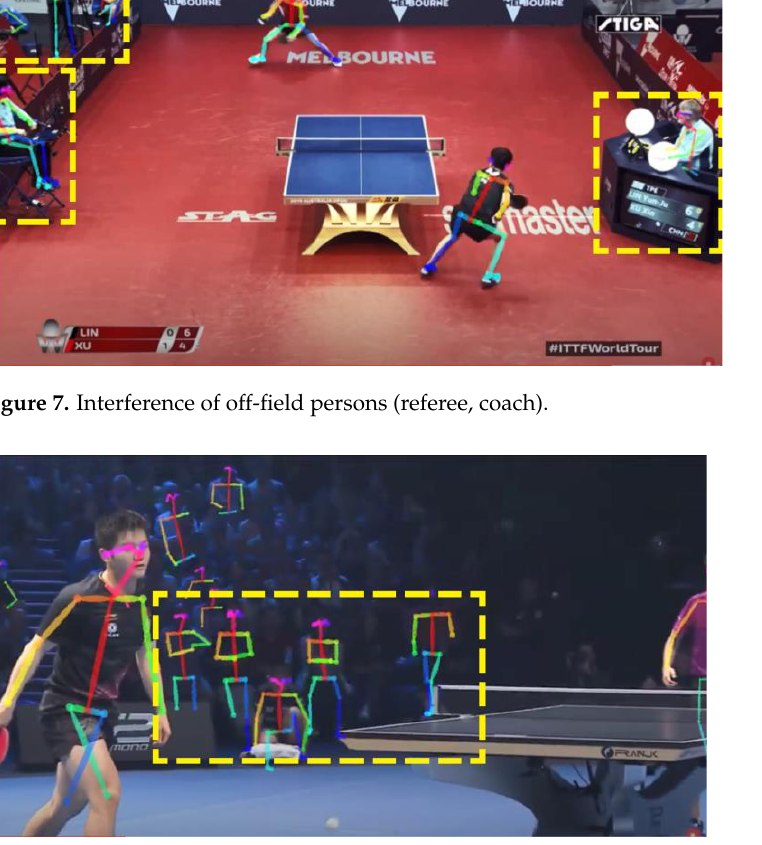
Figure 8. Interference of off-site persons (audience).